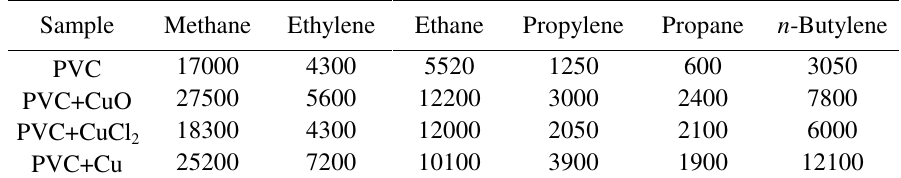
Table 4. Concentration (ppm) of short chain linear gases produced by the combustion of PVC alone and in the presence of some copper compounds under air.